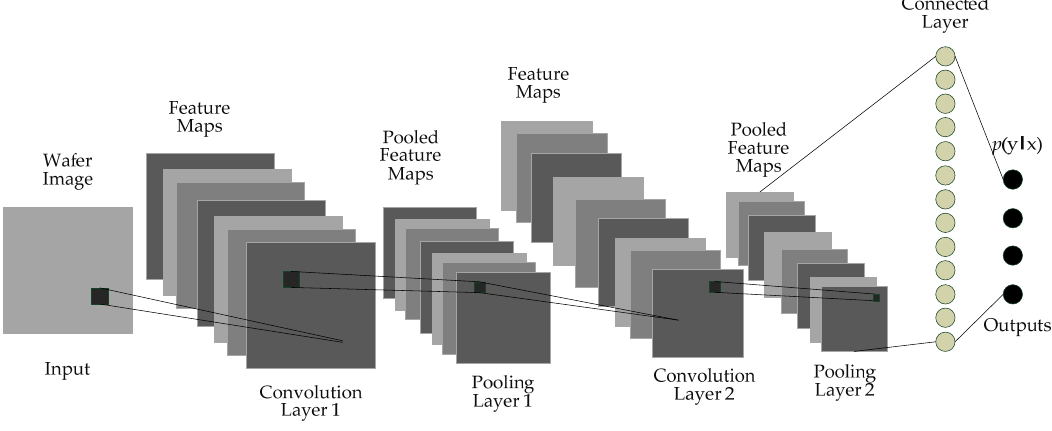
Figure 5. The layers of a convolution neural network.